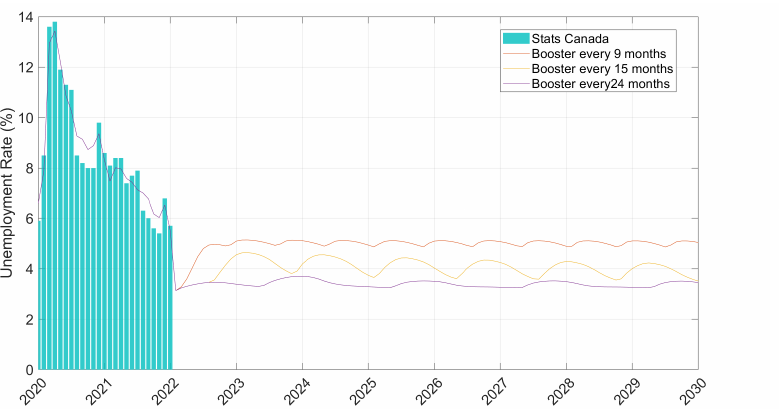
Figure 11. Prediction of monthly unemployment rates considering periodic vaccination booster campaigns with periods of 270, 450, and 720